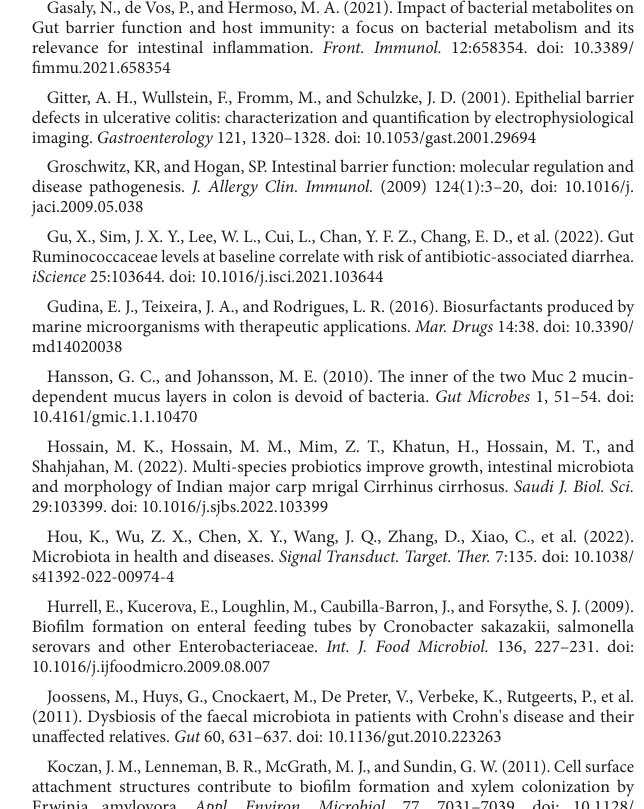
SUPPLEMENTARY FIGURE S3 LP-PBF postbiotic is able to increase Ruminococcaceae family upon infection with S. typhimurium . (A) Bar plots of the phylum-level microbial composition of feces from group of mice treated with S. typhimurium in combination with vehicle (Sal + Vehicle) ( n = 8), and mice treated with S. typhimurium in combination with postbiotic (Sal + LP-PBF) ( n = 8). Relative frequencies are plotted as average of each sample type among the two different experimental groups. (B) Bar plots of the genera-level microbial composition of feces from group of mice treated with S. typhimurium in combination with vehicle (Sal + Vehicle) ( n = 8), and mice treated with S. typhimurium in combination with postbiotic (Sal + LP-PBF) ( n = 8). Relative frequencies are plotted as average of each sample type among the two different experimental groups. (C) Alpha diversity box plot (Chao1 index) of feces ( n =8) coming from mice treated with Sal + Vehicle or Sal + LP-PBF. Data are represented using Box and Whisker plots. Box plots display the first quartile, median and third quartile values and the whiskers extend from the hinge no further than 1.5 times the interquartile range. Statistical analysis was evaluated using Welch two sample t -test, p >0.05. Each data point represents one mouse. (D) Alpha diversity box plot (Shannon Entropy) of feces ( n =8) and LC ( n =8) coming from mice treated with Sal + Vehicle or Sal + LP-PBF. Data are represented using Box and Whisker plots. Box plots display the first quartile, median and third quartile values and the whiskers extend from the hinge no further than 1.5 times the interquartile range. Statistical analysis was evaluated using Welch two sample t -test, p >0.05. Each data point represents one mouse. SUPPLEMENTARY FIGURE S4 LP-PBF does not have anti-bacterial effect on LP-PBF-treated S. typhimurium . Growth curve of S. typhimurium SL1344 (red), S. typhimurium SL1344 pretreated with 5mg/ml of vehicle (blue), and S. typhimurium SL1344 pretreated with 5mg/ml of LP-PBF (white). Growth curve is represented as optical density (OD600) of bacterial suspension at different time